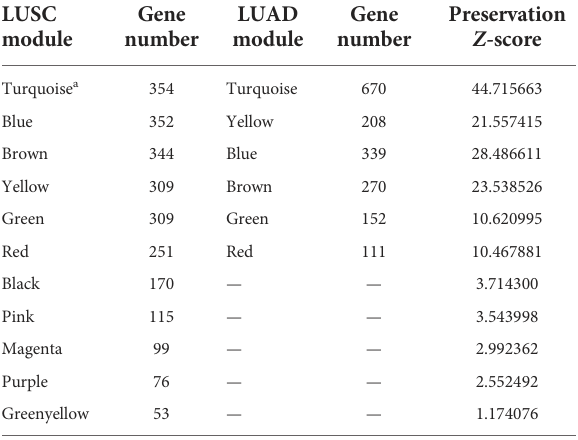
TABLE 1 LUSC and LUAD network module.